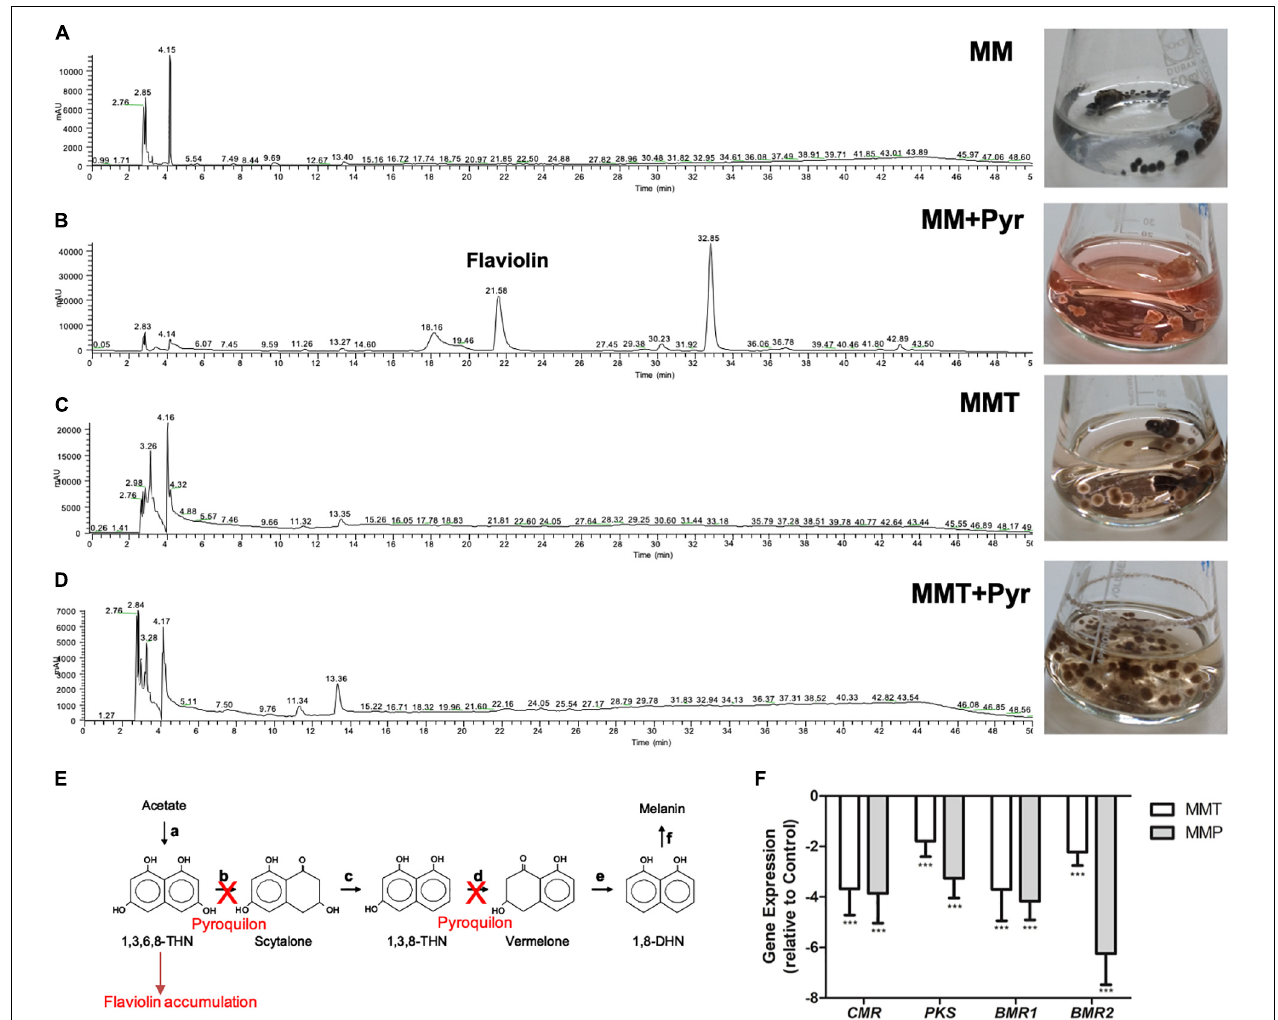
FIGURE 3 | DHN-melanin pathway inhibition in A. alternata under tyrosine metabolism. (A–D) Chromatographic separation of the components of the supernatants of A. alternata grown in (A) MM, (B) MM + pyroquilon, (C) MMT and (D) MMT + pyroquilon and respective growth in the Erlenmeyers. In MM + pyroquilon, the DHN-melanin pathway is inhibition by pyroquilon leads to the released of the carmine shunt product flaviolin. (E) Biosynthetic pathway leading to the formation of DHN-melanin from acetate and identification of the enzymes involved [ (a) , polyketide synthase; (b) , T4HN reductase; (c) , scytalone dehydratase; (d) , T3HN reductase; (e) , vermelone dehydratase; (f) , several candidate enzymes for this step] in fungi. 1,3,6,8-THN = 1,3,6,8-tetrahydroxynaphthalene; 1,3,8-THN = 1,3,8-trihydroxynaphthalene; 1,8-DHN = 1,8-dihydroxynaphthalene. Pyroquilon inhibits the T4HN reductase and the T3HN reductase which leads to the accumulation of flaviolin (Wheeler and Klich, 1995). (F) Analysis of the expression of CMRA , PKS , BRM1 , BRM2 in A. alternata mycelium cultured in MM, MMT and MMP. Strains were grown for 3 days before mycelium was harvested and RNA isolated. RT-PCR was performed as described in section “Materials and Methods” with the ß-tubulin gene as standard and in comparison to the control MM. Results are the mean ± standard errors of the means (SEMs) of triplicates of three independent experiments (Mann-Whitney, Prism): *** P <